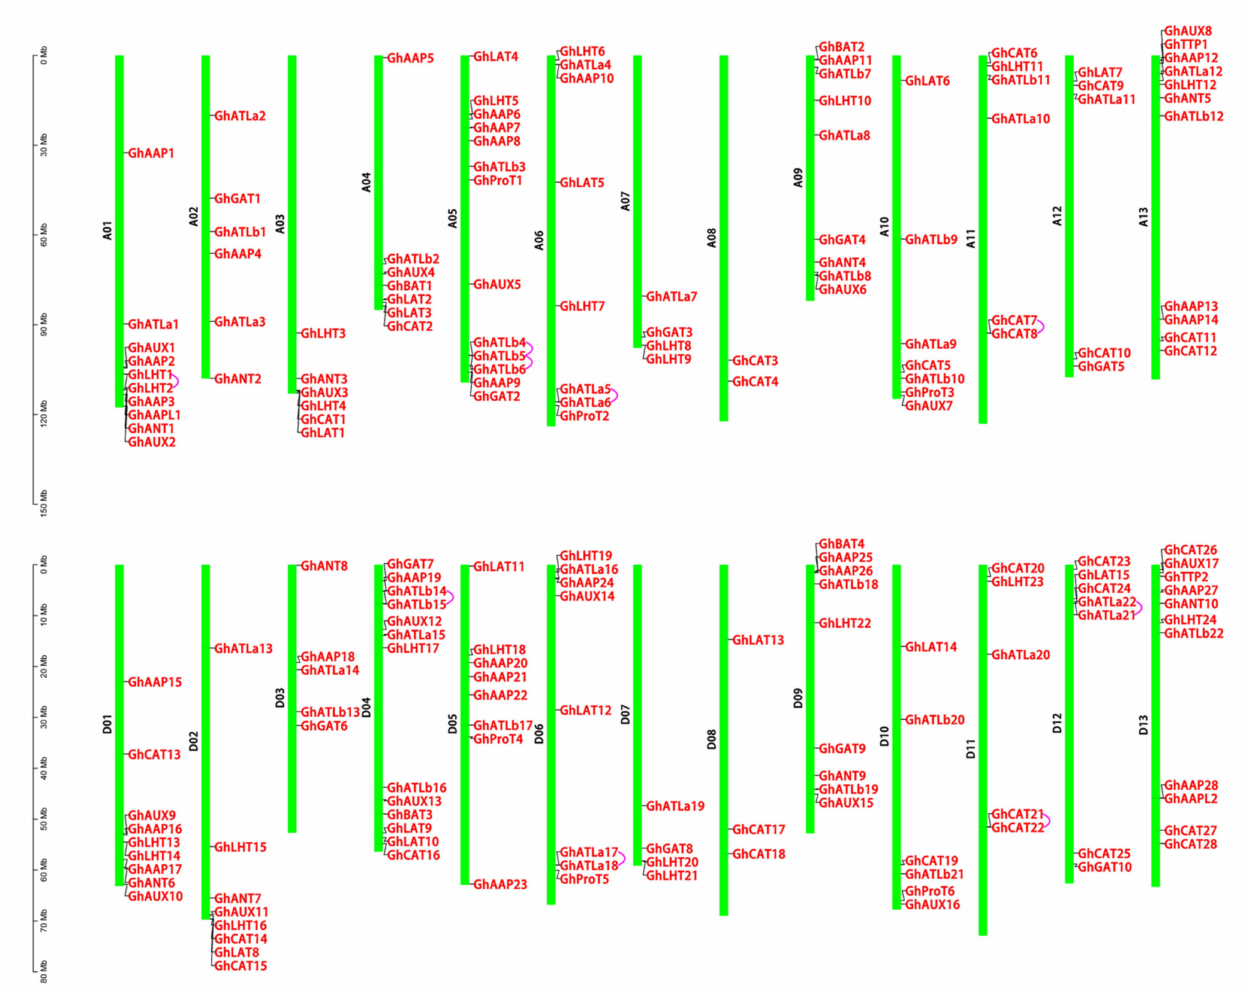
Figure 2. Chromosomal distribution of AATs in G. hirsutum L. The scale represented megabases (Mb). The chromosome IDs were indicated beside each vertical bar. The AATs were displayed on different chromosomes. Green bars represented the physical maps of chromosomes in G. hirsutum L. and the purple short arc linked genes were the tandem repeat genes in